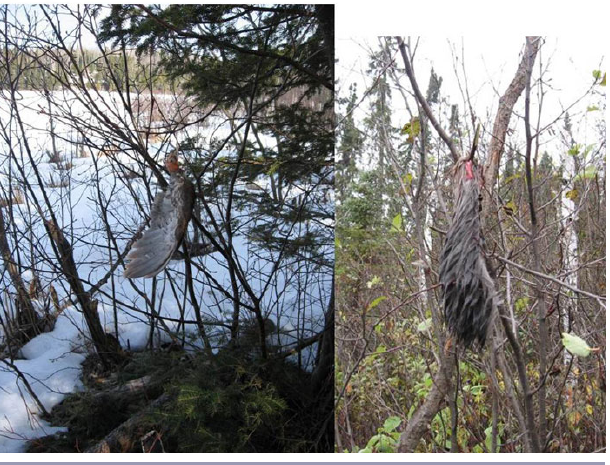
Fig. 3 . Following a successful hunt Pikangikum hunters show respect to the animals that have given their lives by hanging a wing (Spruce Grouse, Falcipennis canadensis ) or the “beard” of the moose ( Alces alces ). Doing so is believed to contribute to renewal of these animals. (Photo: A. M.